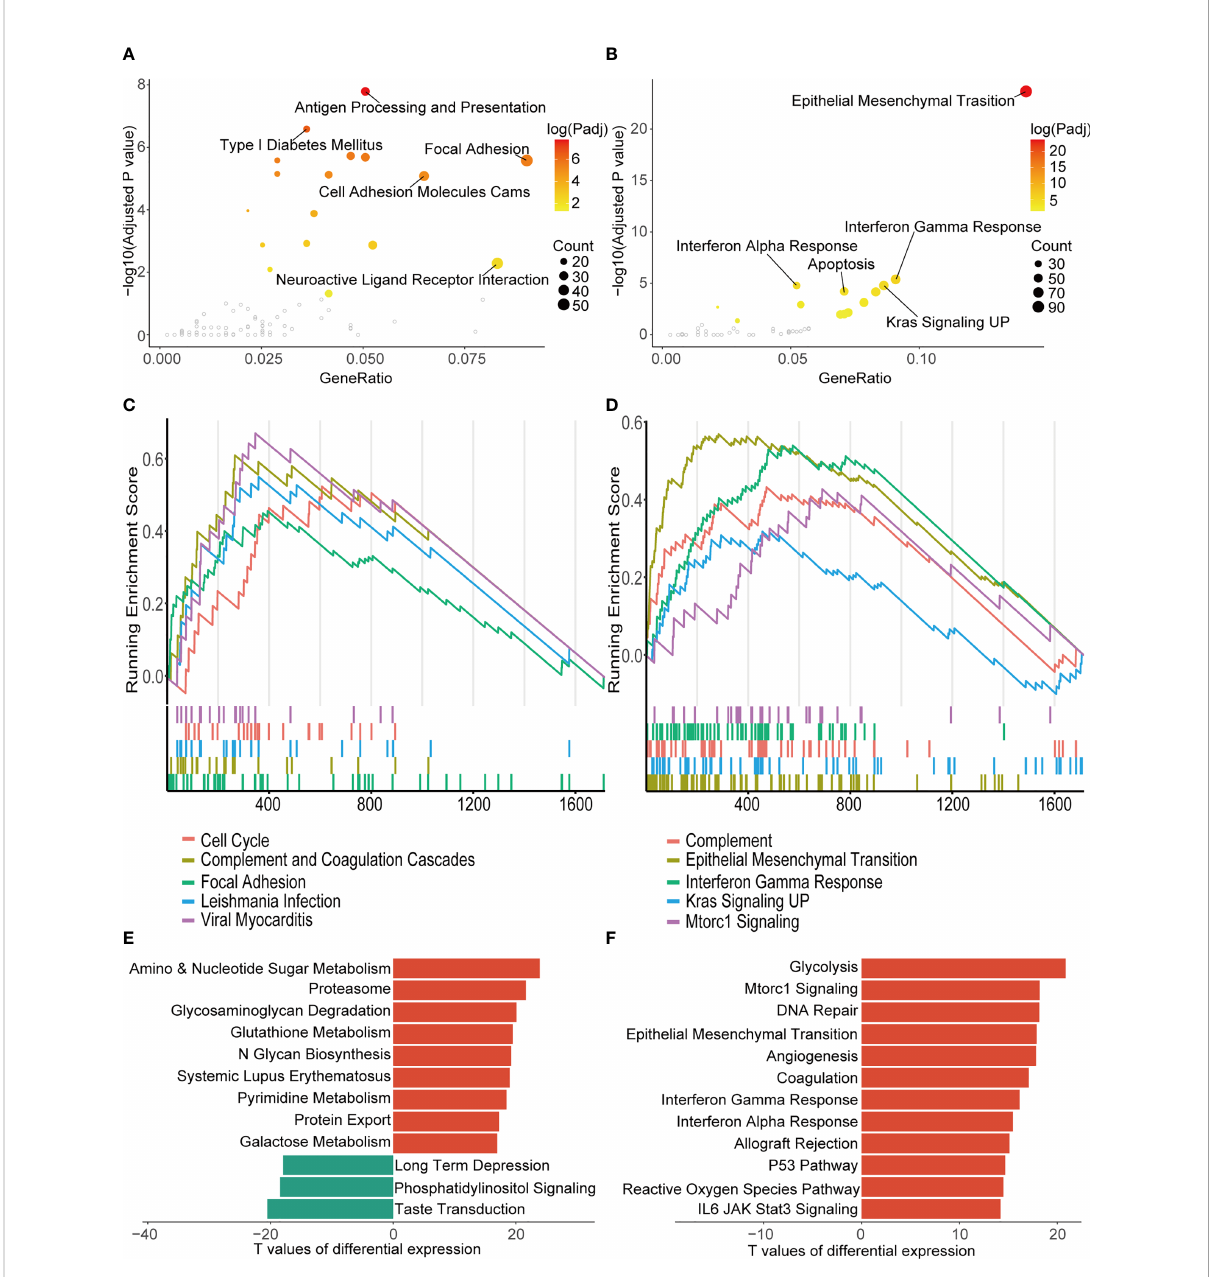
FIGURE 4 Biological function analysis of DEGs between the two consensus clusters. (A, B) Top fi ve over-represented pathways in KEGG (A) and HALLMARK (B) annotation of the DEGs. (C, D) Top fi ve pathways with the highest normalized enrichment score of GSEA in the KEGG (C) and the HALLMARK gene sets (D) . (E, F) Ten pathways with smallest adjusted p-value of GSVA in KEGG (E) and HALLMARK pathways (F) . TCGA, The Cancer Genome Atlas; KEGG, Kyoto Encyclopedia of Genes and Genomes; GSEA, gene set enrichment analysis; UP, upregulation; GSVA, gene set variation